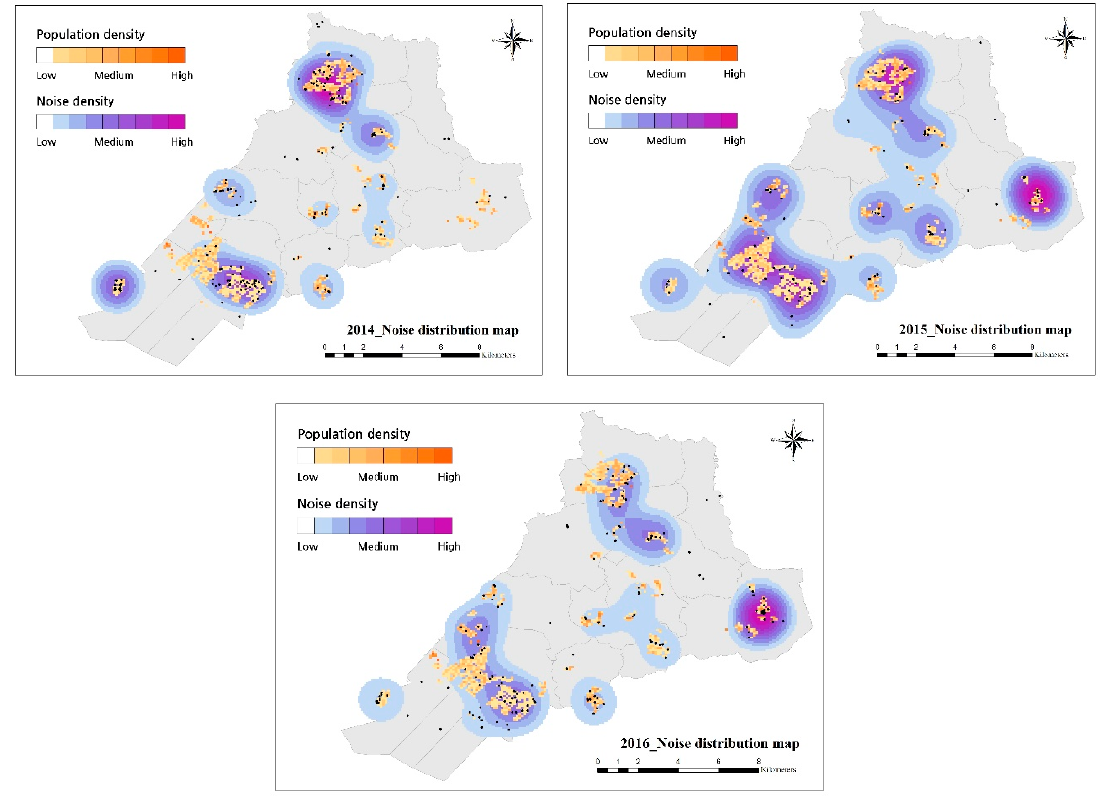
F igure 8. Annually the noise distribution map. Figure 8. Annually the noise distribution